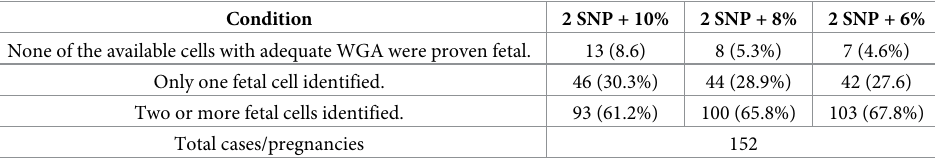
Table 2. Tabulation of cases according to outcome of genotyping. Condition 2 SNP + 10% 2 SNP + 8% 2 SNP + 6% None of the available cells with adequate WGA were proven fetal. Only one fetal cell